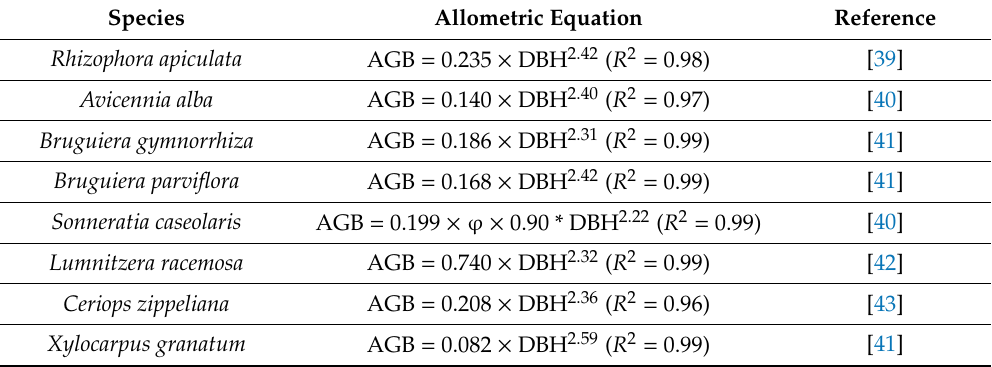
Figure 2. Aboveground biomass measurements in the study area. ( a & b ) Biophysical parameters measurement (Photographs were taken by L.V. Nguyen during the 2018 dry season). The mangrove AGB of each species was estimated by a specific allometric equation (see Table 1). Table 1. Allometric equations for estimating the mangrove species in the study site.